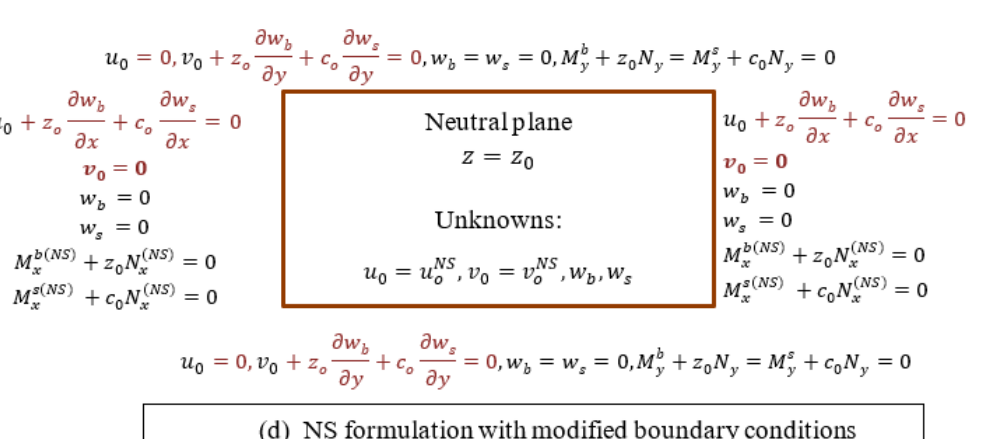
Figure 2. MS and NS formulations with classical and modified BCs for immovable simply supported ( S im ) BDFG plates.